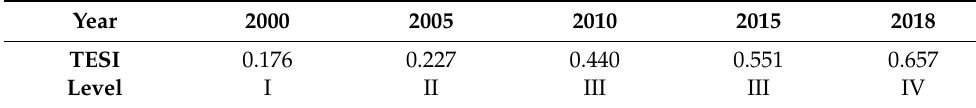
Table 3. TESI of Huanggang Dabieshan UGGp from 2000 to 2018.